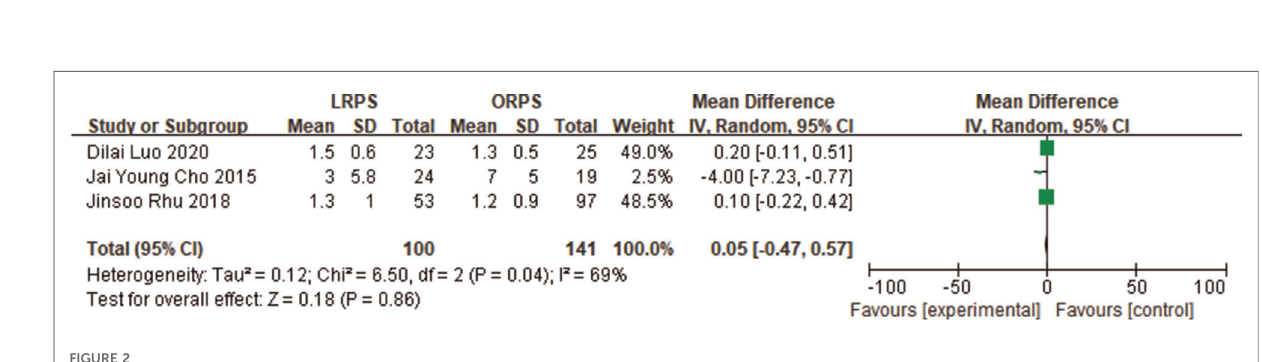
FIGURE 2 Pooled meta-analysis of margin comparing LRPS with ORPS.